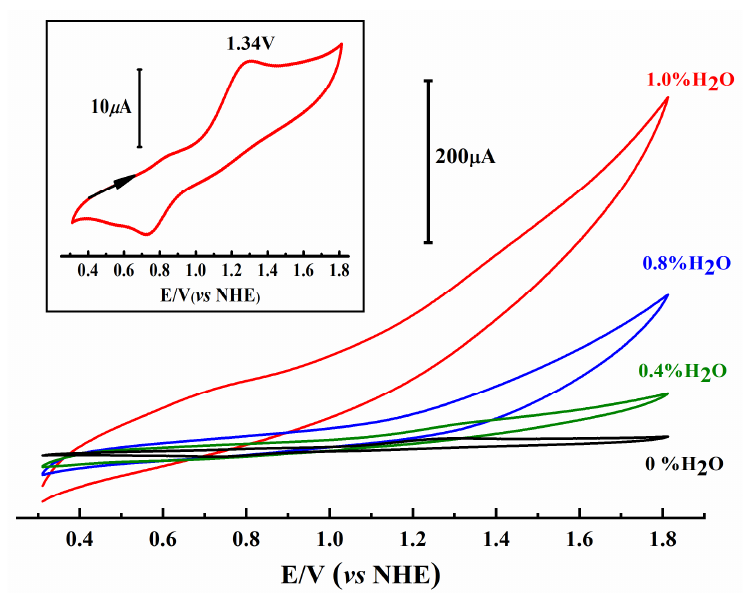
Figure 12. Catalytic properties of the artificial Mn 4 CaO 4 -cluster [118]. Cyclic voltammogram (CV) measurement of the artificial Mn 4 CaO 4 -complex in acetonitrile with different amounts of H 2 O. The inset shows the CV without H 2 O (0% H 2 O).